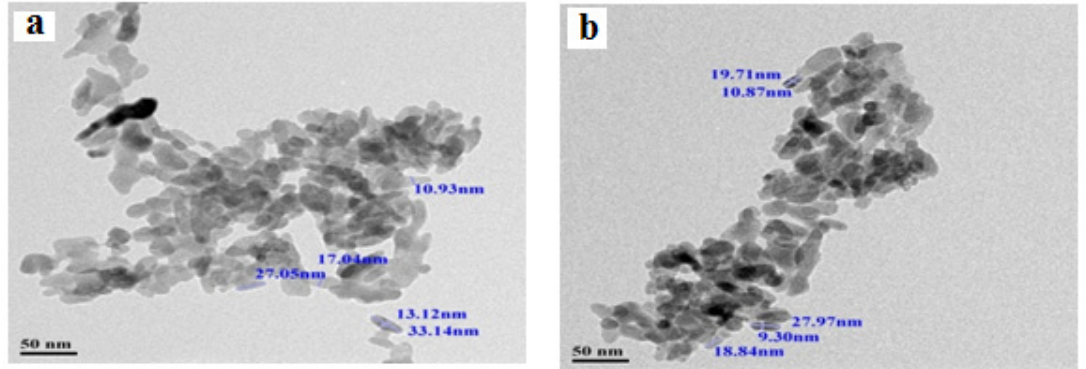
Figure 4. TEM images of the γ -Fe ( b ) “recovered” catalyst after the fifth run. Reprinted with permission from [52]. Copyright 2012 Royal Society of Chemistry.